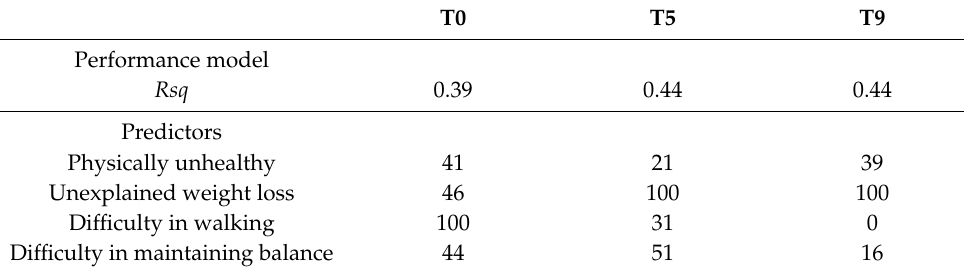
Table 6. Rsq -values and relative importance TFI items for the IADL disability